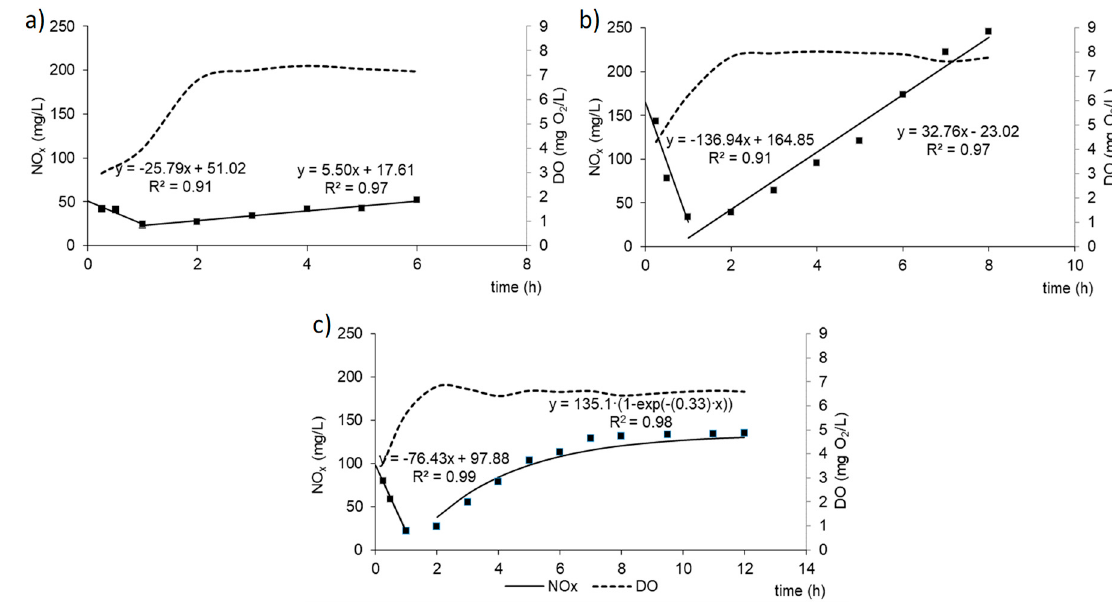
Figure 3. Kinetics of NO x and dissolved oxygen (DO) changes in the cycle of GSBR 6h ( a ), GSBR 8h ( b ), and GSBR 12h ( c ).